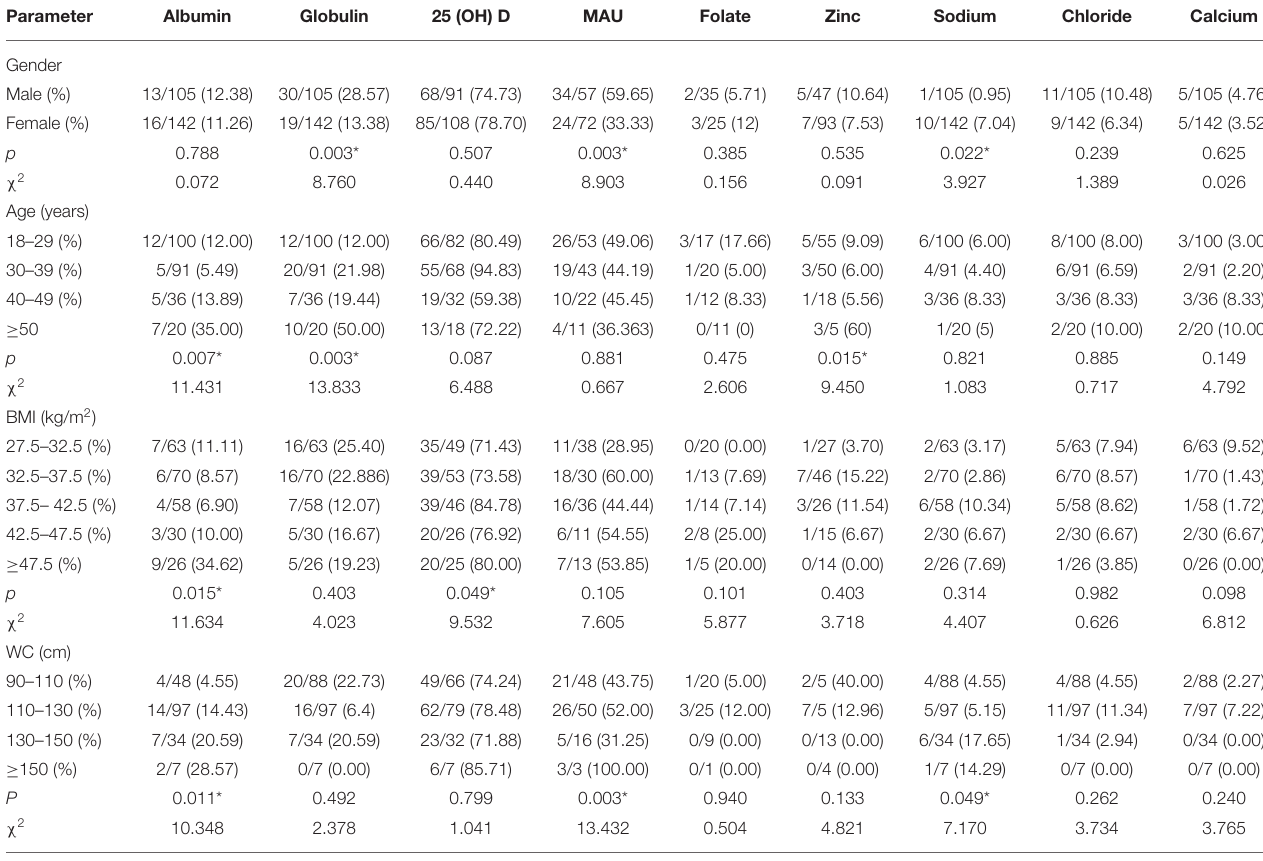
TABLE 3 | Associations between nutritional deficiencies and different physical states.